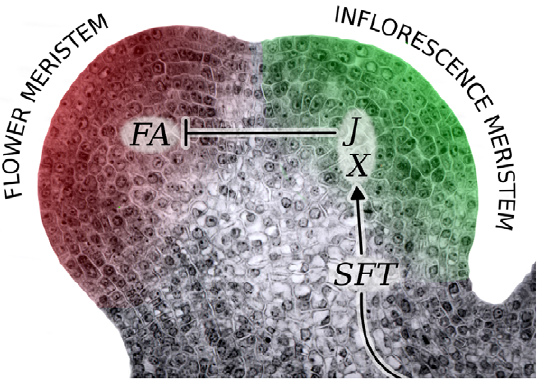
Figure 5. Hypothetical model of genetic interactions shaping the inflorescence of tomato. At floral transition, the SAM forms a flower meristem (FM) and a lateral meristem arises adjacently. JOINTLESS ( J ) and an unknown target (X) of the systemic SINGLE FLOWER TRUSS (SFT) protein prevent early FM maturation in the lateral meristem and so allow an inflorescence meristem (IM) fate. This involves repression of the FM identity gene FALSIFLORA ( FA ) by J in the IM.